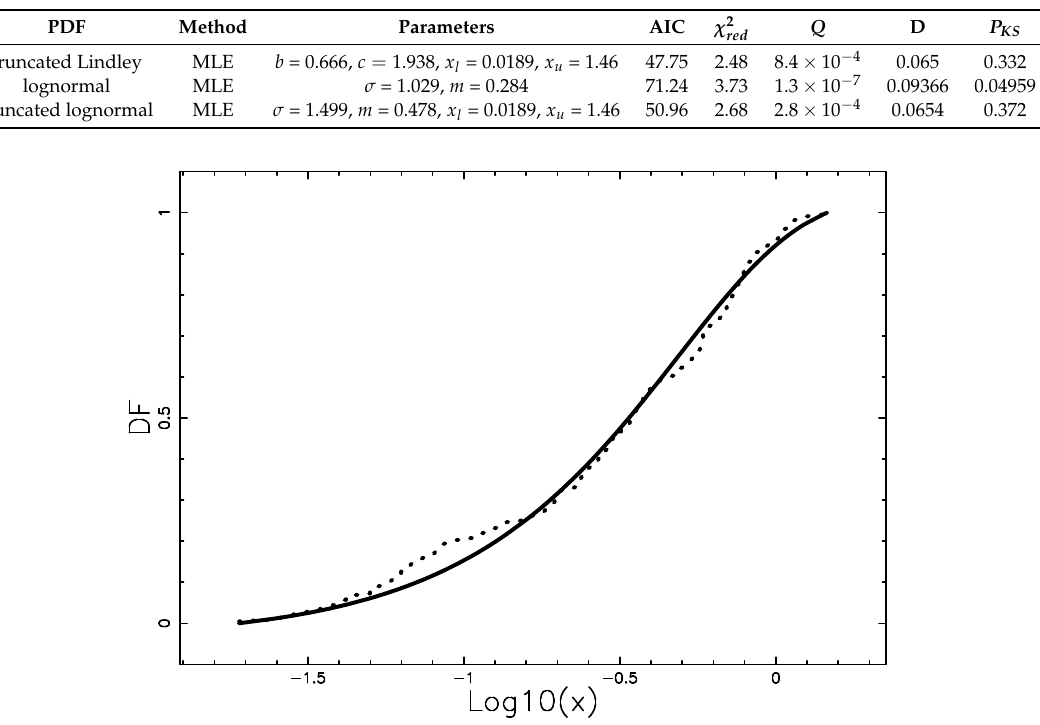
Figure 3. Empirical DF of mass distribution for NGC 6611 cluster data (207 stars + BDs) when the number of bins, n , is 20 (dotted points ) with a superposition of the truncated Lindley DF (full line). Theoretical parameters as in Table 1, MLE method. The horizontal axis has a logarithmic